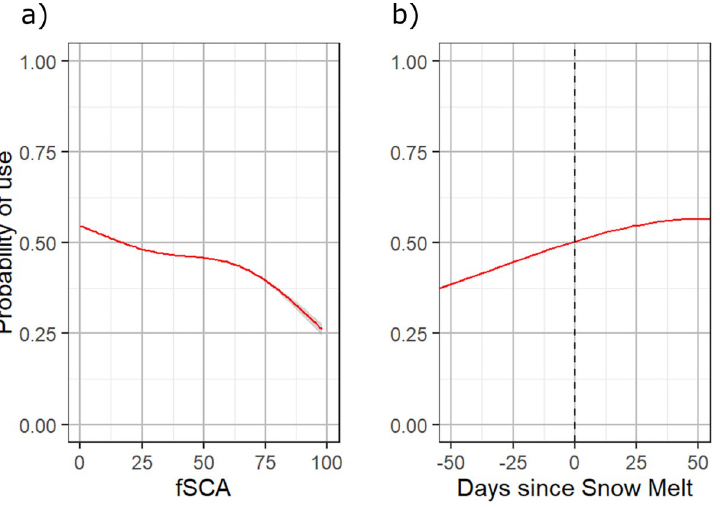
Fig 4. Probability of use was calculated over all available locations with both fSCA and DSM on the x-axis. The overall trends show increased selection for locations with less snow cover than what is available, as well as preference for locations where snow melted sooner in the spring.